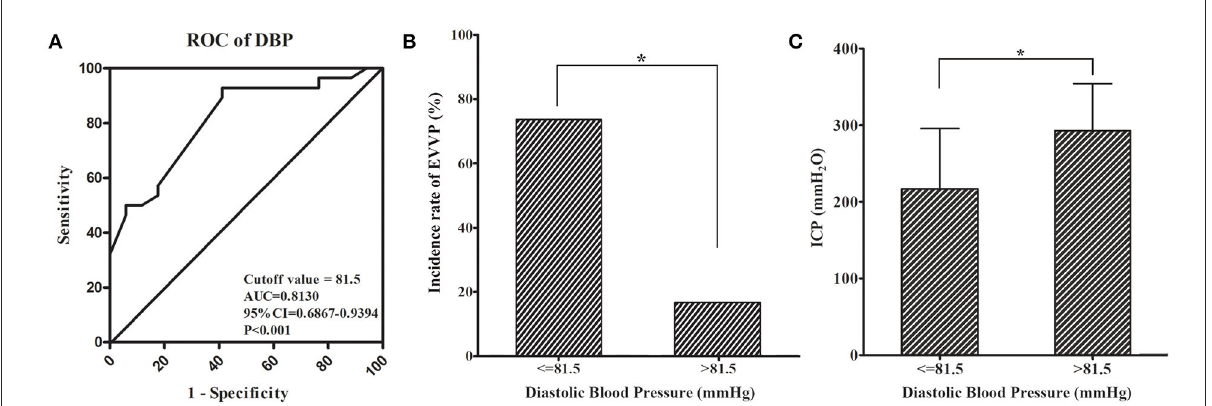
FIGURE1 Receiver operating characteristic curve showed that DBP ≤ 81.5 mmHg indicated the presence of EVVP in BTSS patients (A) . The incidence of EVVP was significantly higher (B) and ICP was significantly lower (C) in BTSS patients with DBP ≤ 81.5 mmHg than those with DBP > 81.5 mmHg. * p < 0.05. BTSS, bilateral transverse sinus stenosis; DBP, diastolic blood pressure; EVVP, enlarged vertebral venous plexus; ICP, intracranial